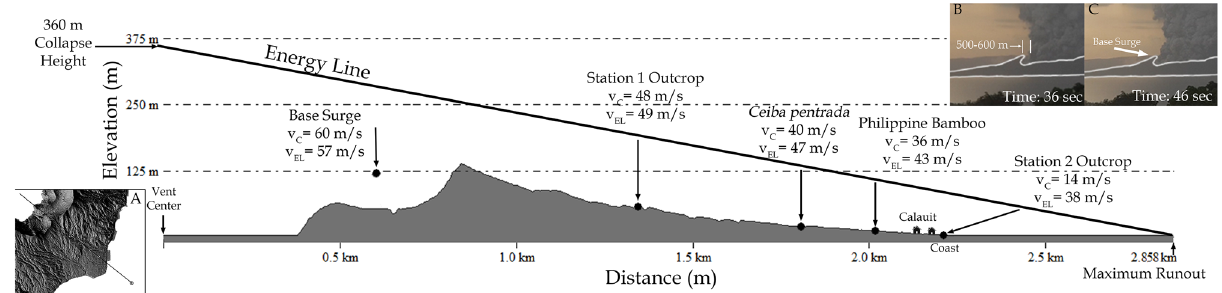
Figure 7. Projection of energy line model along the southeast profile of Taal Volcano Island where observation and calculation points for velocity are located from the vent center to the projected maximum runout distance. Velocities calculated using different methods (vC) and velocities calculated using the energy line model (vEL) for each of the four observation points are shown. ( A ) Location of southeast profile and observation points. ( B ) Image from timelapse video at 36 seconds showing 500–600 m open area within the southeast inner crater. ( C ) Image from time-lapse video at 46 seconds showing the area from B being covered by a moving base